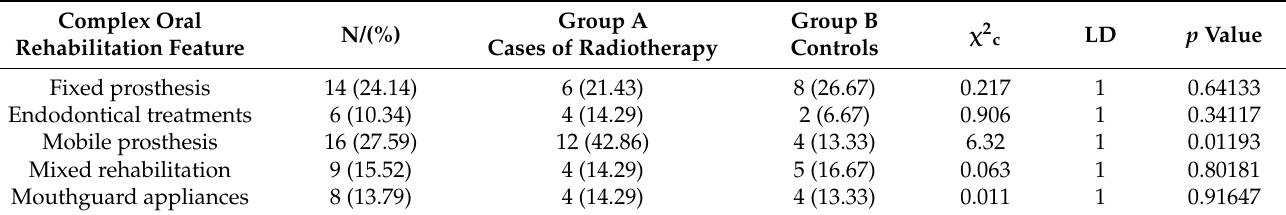
Table 9. Complex oral